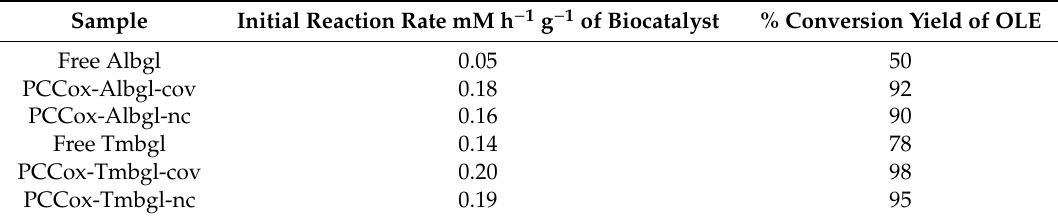
Table 5. Initial reaction rates of immobilized β -glucosidase on PCC and PCCox for the hydrolysis of oleuropein (OLE) and percentage conversion yield of OLE after 24 h of incubation in citrate phosphate bu ff er 100 mM, pH 5.0, and pH 6.5 for Albgl and Tmbgl, respectively, at 37 ◦ C (the standard deviation was less than 5% in all cases).